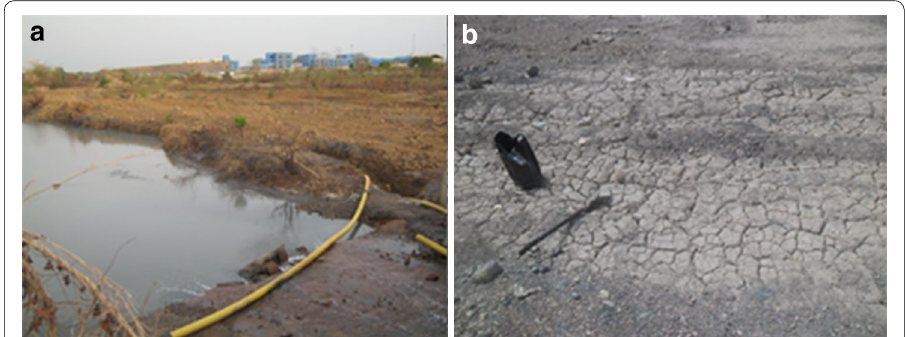
Fig. 11 Evidences of Smectite minerals. a Flooding, b soil